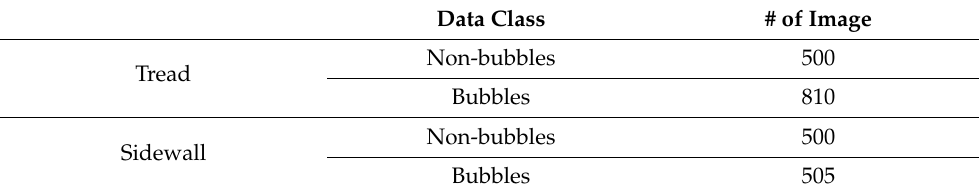
Table 2. Testing